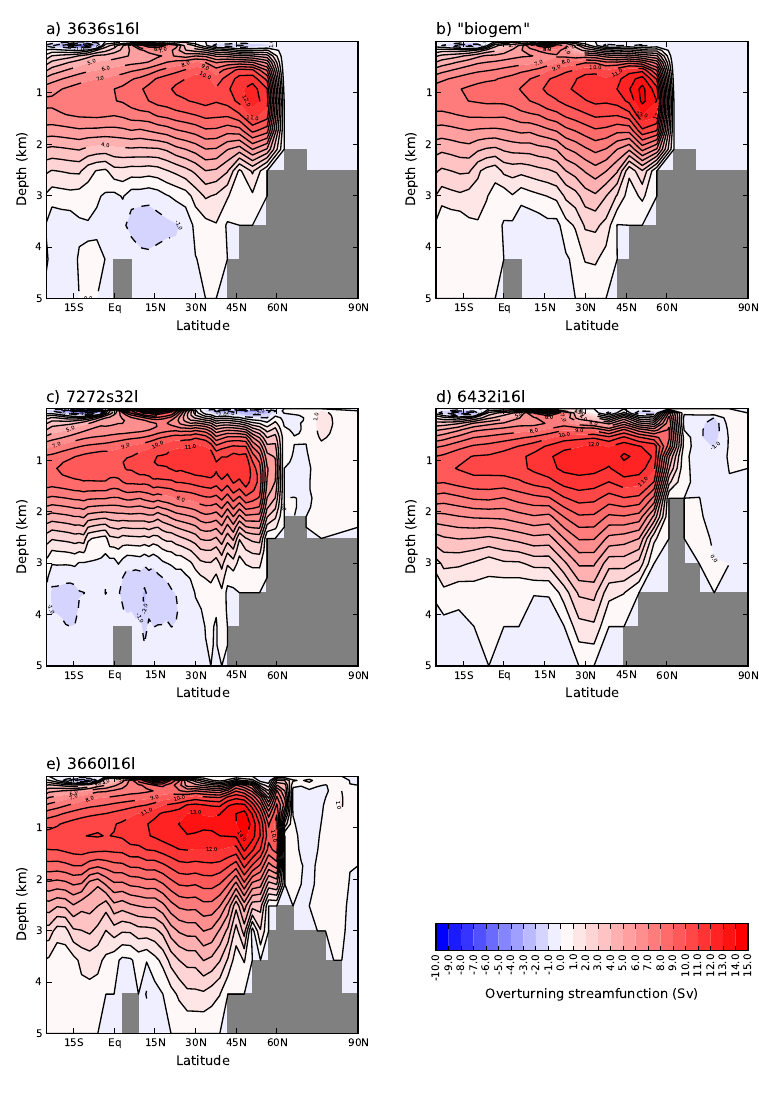
Fig. 21. Atlantic meridional overturning streamfuctions (Sv) in the five experiments. Contour interval is 1Sv